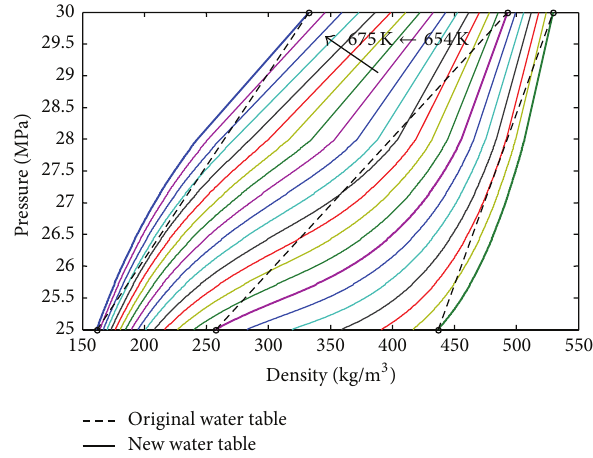
Figure 4: Density versus pressure in isotherm from original and modified water tables of